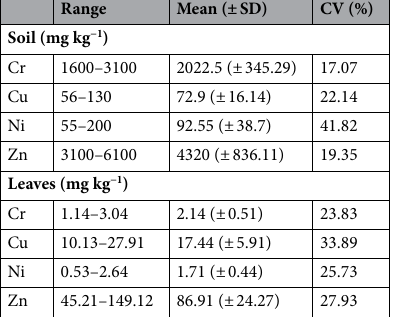
Table 1. Heavy metal contents observed in the soil and in the leaves of R. fruticosus L. on the brownfield site ( CV coefficient of